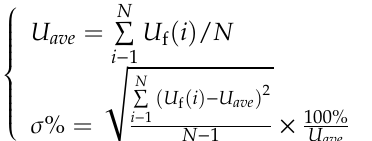
Figure 12. Schematic diagram of staining in the tests.